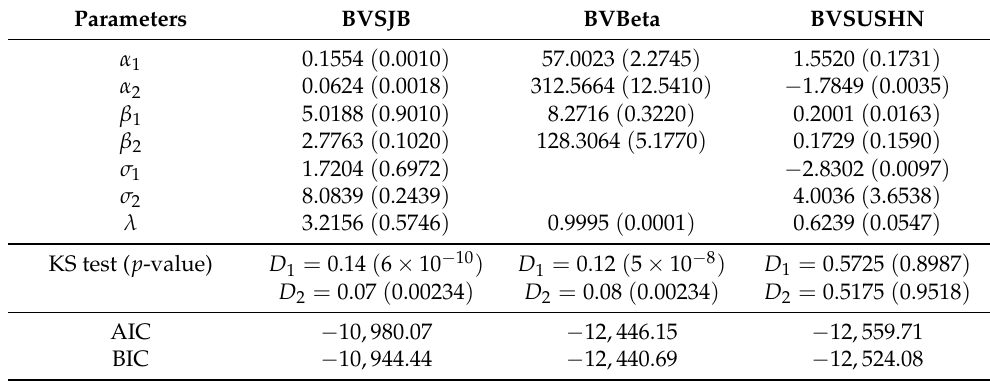
Table 3. MLE (SE) for BVBeta, BVSJB, and BVSUSHN models.